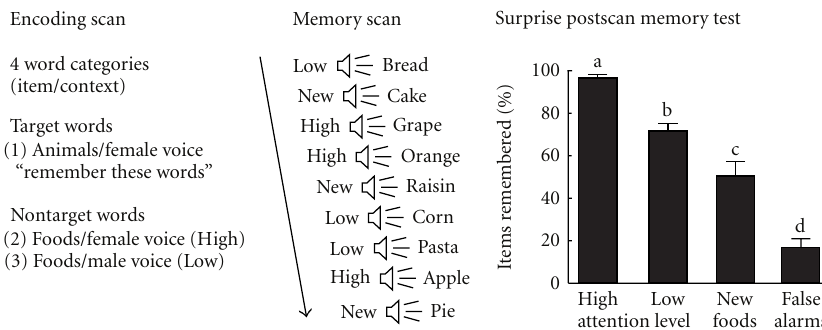
Figure 1: Experimental design for studying incidental encoding and memory. During the Encoding scan [39], listeners were presented with a list of single nouns (animals or foods). Half of the words were recorded in a female voice, and half in a male voice, thus yielding multiple combinations of item and voice context. Throughout the experiment, listeners’ attention was focused on only one subset of words: animal words presented in the female voice ( Target words). This was accomplished first by giving them explicit instructions to select and remember these words during the Encoding scan , and later, by instructing them to select these items by responding “yes” during the Memory scan . However, as predicted, some of the Nontarget words were also encoded unintentionally, with food words presented in the female voice carrying greater salience (the High-Attention condition) than food words presented in the male voice (the Low-Attention condition). During the Memory scan , participants were presented once again with both High- and Low-Attention food words, along with novel food words ( NEW ) as a control category representing the baseline attention condition. Following the Memory scan , a Surprise memory test was used to confirm the extent to which High-Attention , Low-Attention , and NEW food words were successfully encoded. The chart at right shows the group-averaged memory scores ( N = 13; means ± SEM) for these three word categories, along with ten foils to measure false alarm rate. Bars capped by di ff erent letters are significantly di ff erent at P < 0 . 001 (two-tailed